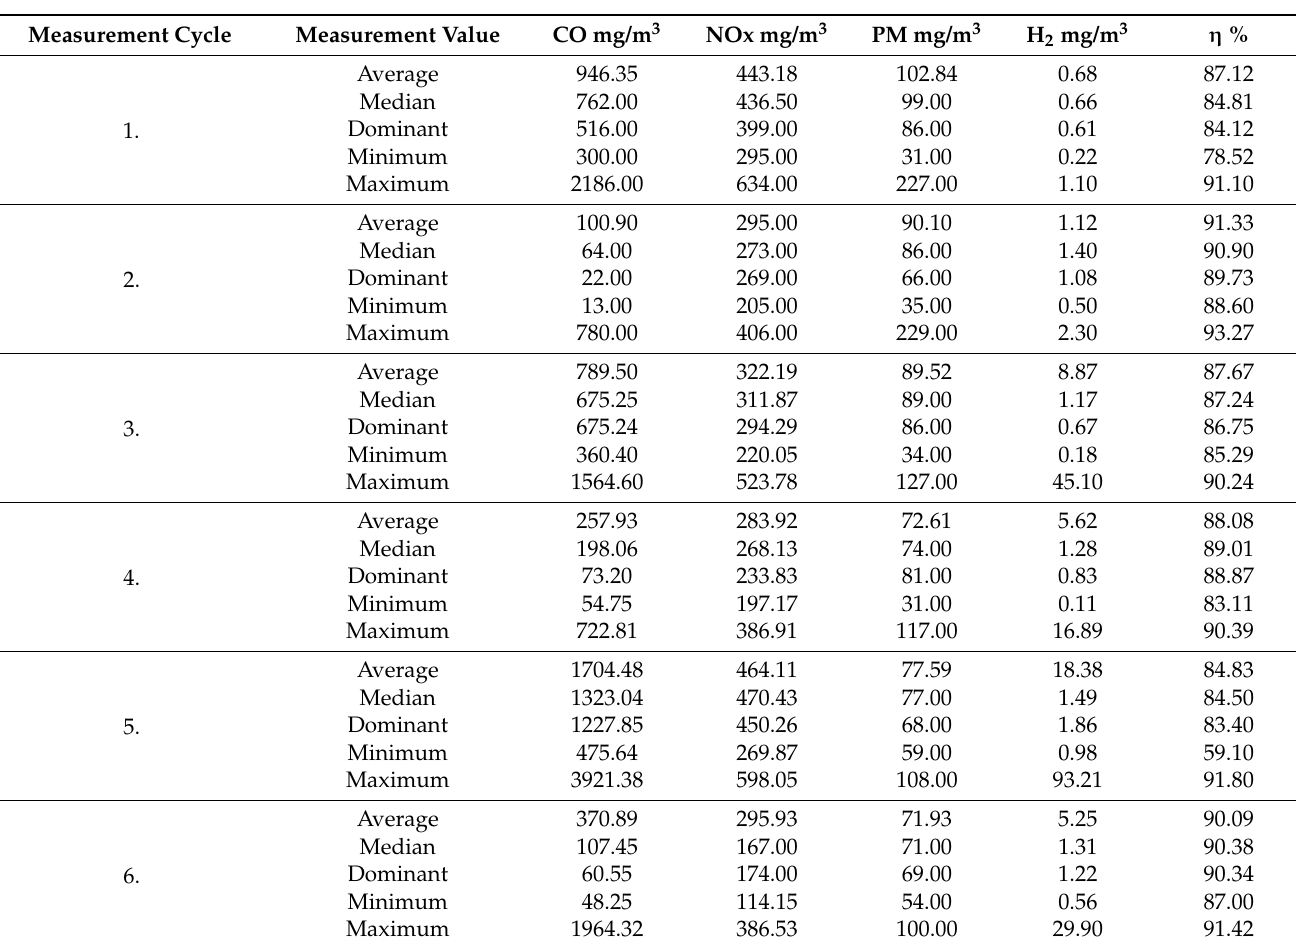
Table 4. Results of the first stage of